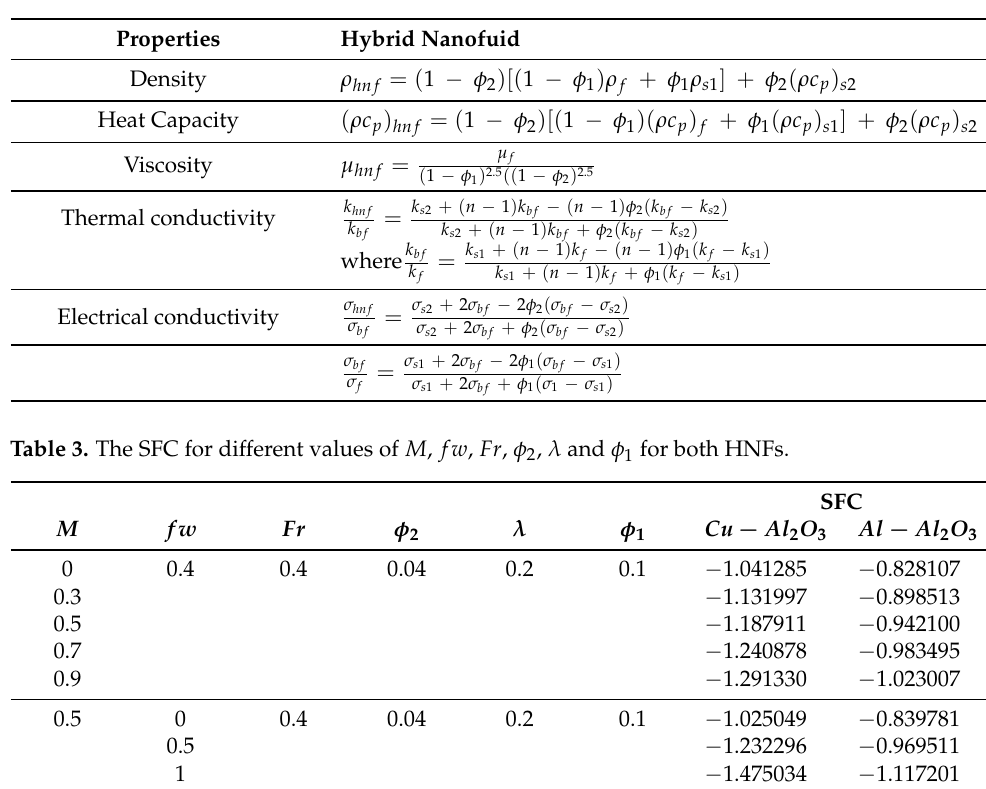
Table 2. Thermophysical properties of Hybrid nanofluid.